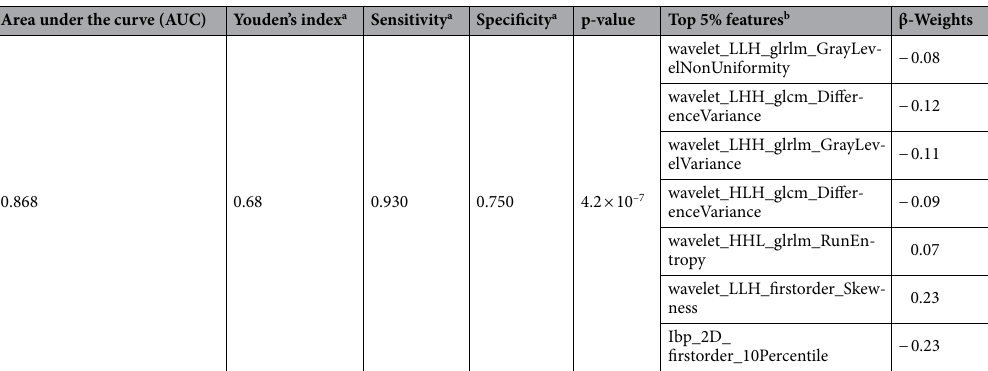
Table 2. Diagnostic performance of the radiomics-based machine learning signature including area under the curve (AUC), Youden’s index, sensitivity, specificity and p-value. In the last two columns on the right, the 5% features with the largest β-weights in magnitude (top 5% features) and their β-weights. a Youden’s test. b 5% features with the largest β-weights in magnitude in Partial Least Square